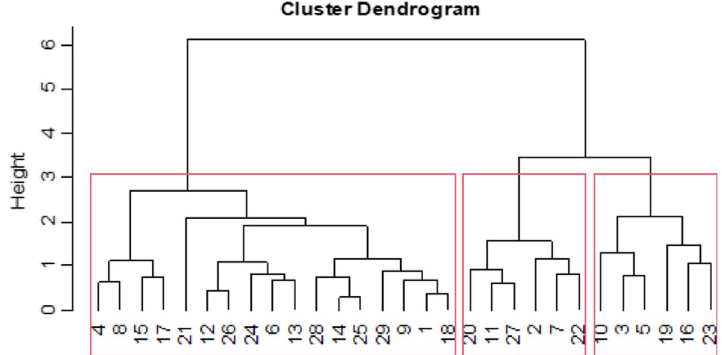
Fig. 12 Cluster dendrogram with time series correlation in stage